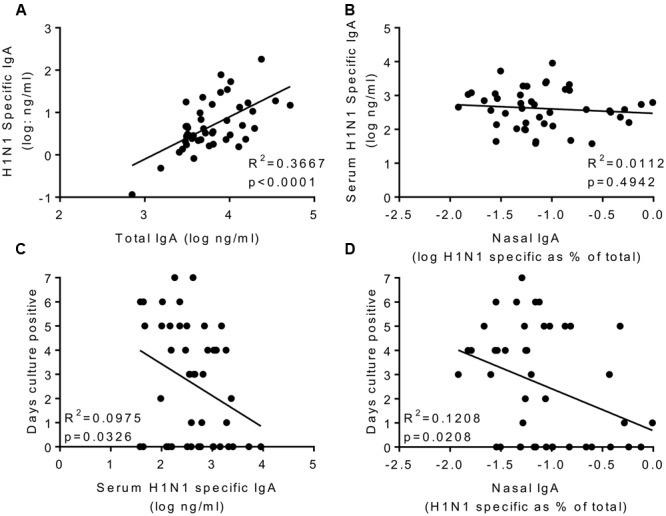
H1N1 specific IgA in nasal wash and serum correlate weakly with protection. H1N1 specific IgA and total IgA were measured in the nasal wash samples collected on day-1 prior to infection (A). H1N1 specific IgA responses were compared between nasal wash and serum (B). Days culture positive virus was recoverable compared to serum IgA (C) and nasal IgA (D). Data pooled from two studies, n = 47 volunteers.